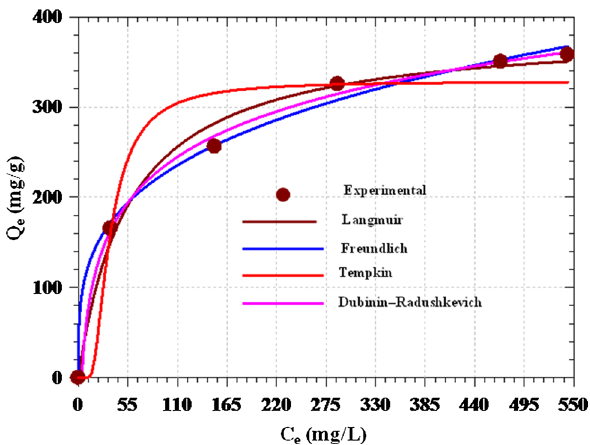
Fig. 7 Nonlinear isotherm plots of: a Langmuir, b Freundlich, c Tem- kin, d DB-R for adsorption at 323 K